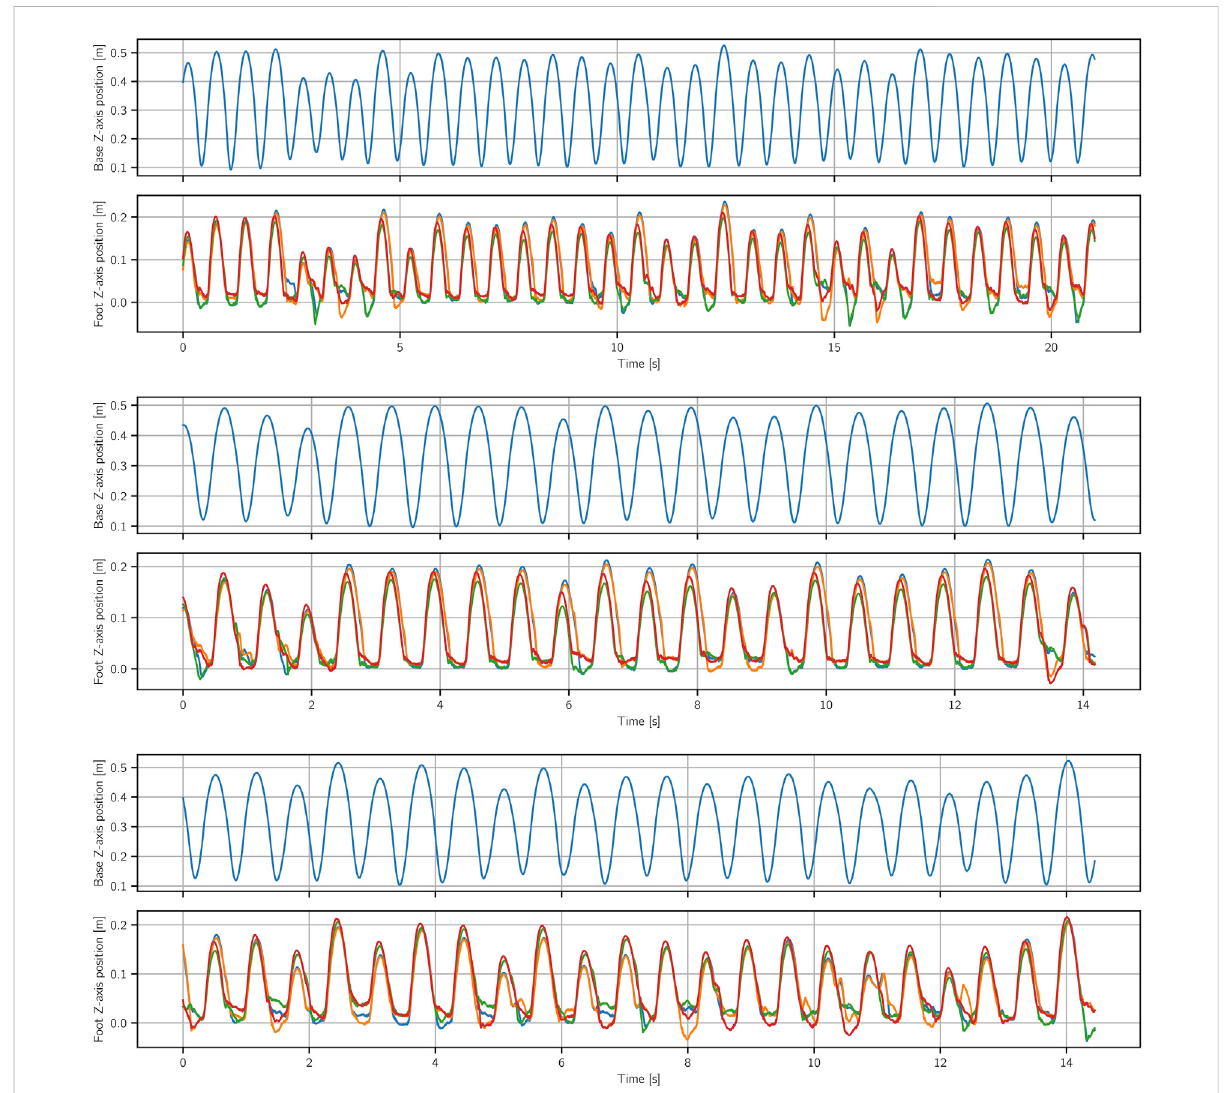
FIGURE 4 Threedifferentexecutionofajumpingpolicyintherealworldonarandomuneventerrainwith5 cmheightuncertainty.Aswecansee,different feet land on different height in each jump, but the policy manages to keep the jumping height within a certain